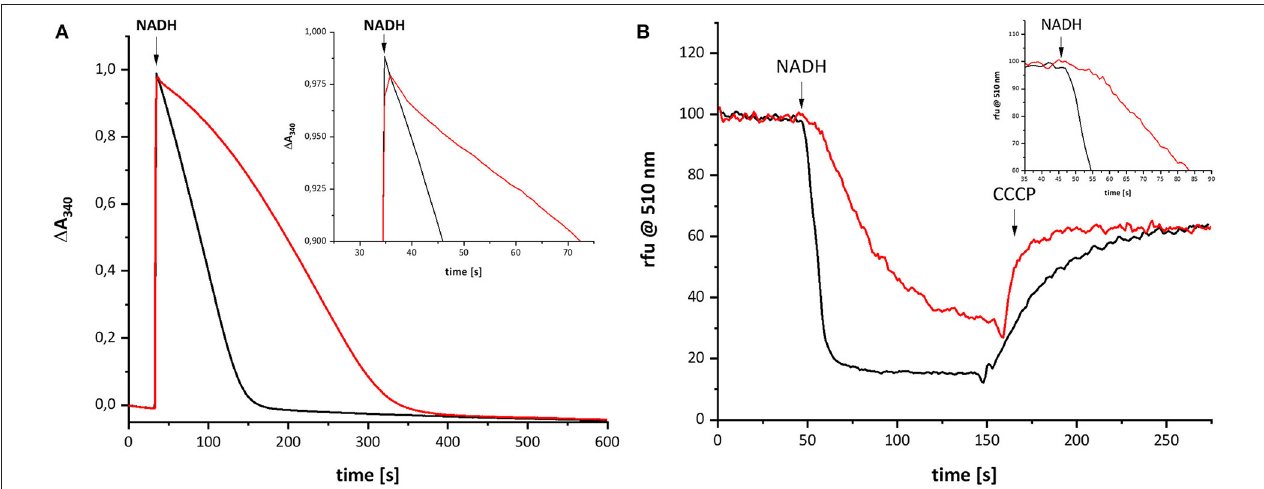
FIGURE 5 | Catalytic activities of wild type complex I (black) and the D213G H variant (red). (A) Shows the NADH:decyl-Q oxidoreductase activity and (B) the quench of the ACMA fluorescence after reconstitution of the preparations into proteoliposomes. The proton gradient established by the catalytic activity of complex I is dissipated by an addition of carbonyl cyanide 3-chlorophenylhydrazone (CCCP). The insets show the initial activities with a magnified scale.